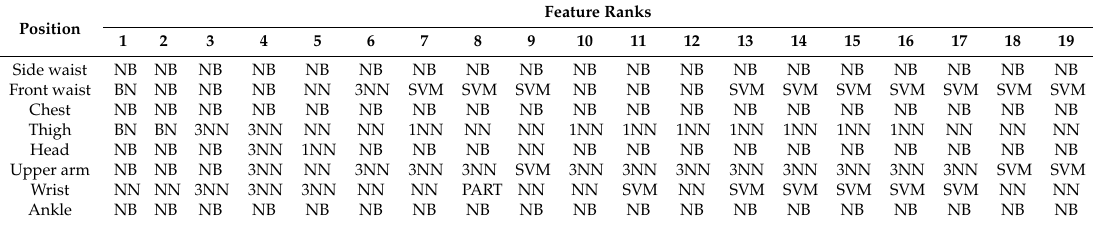
Table 4. Best algorithms for different numbers of features and sensor positions.